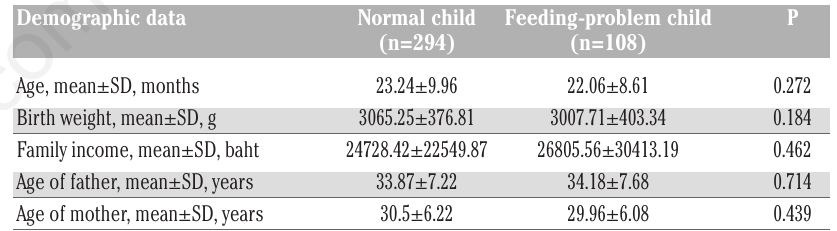
Table 1. Comparison of socio-demographic characteristics between normal and feeding- problem children.